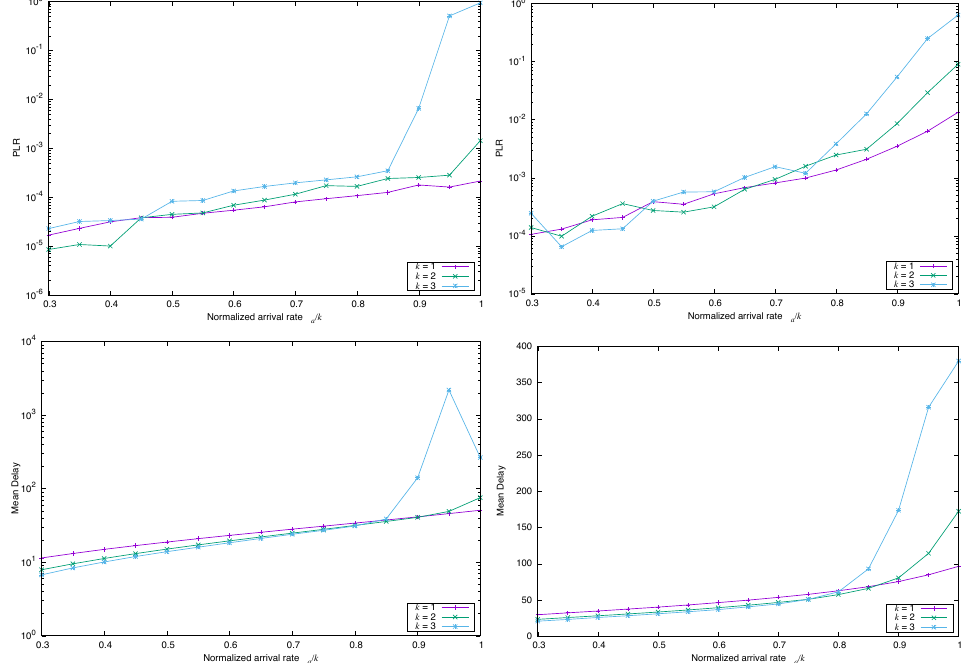
Figure 9. Simulated PLR ( top ) and Mean Delay ( bottom ) for FA-CSA versus λ a / k , with Λ ( x ) = 0.86 x 3 + 0.14 x 8 , n = 200 and k = { 1,2,3 } , and marginal distribution Lognormal, with σ 2 = 1.1 µ 2 ( left ) and σ 2 = 4 µ 2 ( right